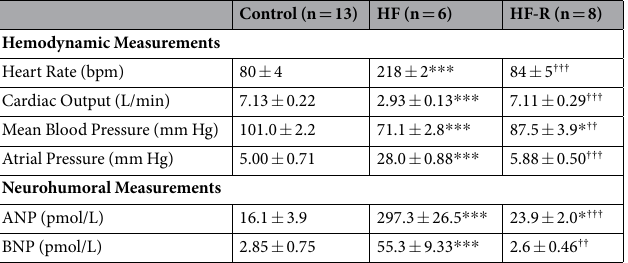
Table 1. Hemodynamic and neurohormonal changes in an ovine model of rapid pacing-induced heart failure and recovery. Mean ± SEM measurements in normal Control sheep and sheep subject to heart failure induced by rapid left ventricular pacing at ~220 bpm for 13 days (HF) and following recovery from heart failure after 26 days cessation of pacing (HF-R). Atrial natriuretic peptide (ANP); B-type natriuretic peptide (BNP). * P < 0.05 and *** P < 0.001 vs Control; †† P < 0.01 and ††† P < 0.001 vs